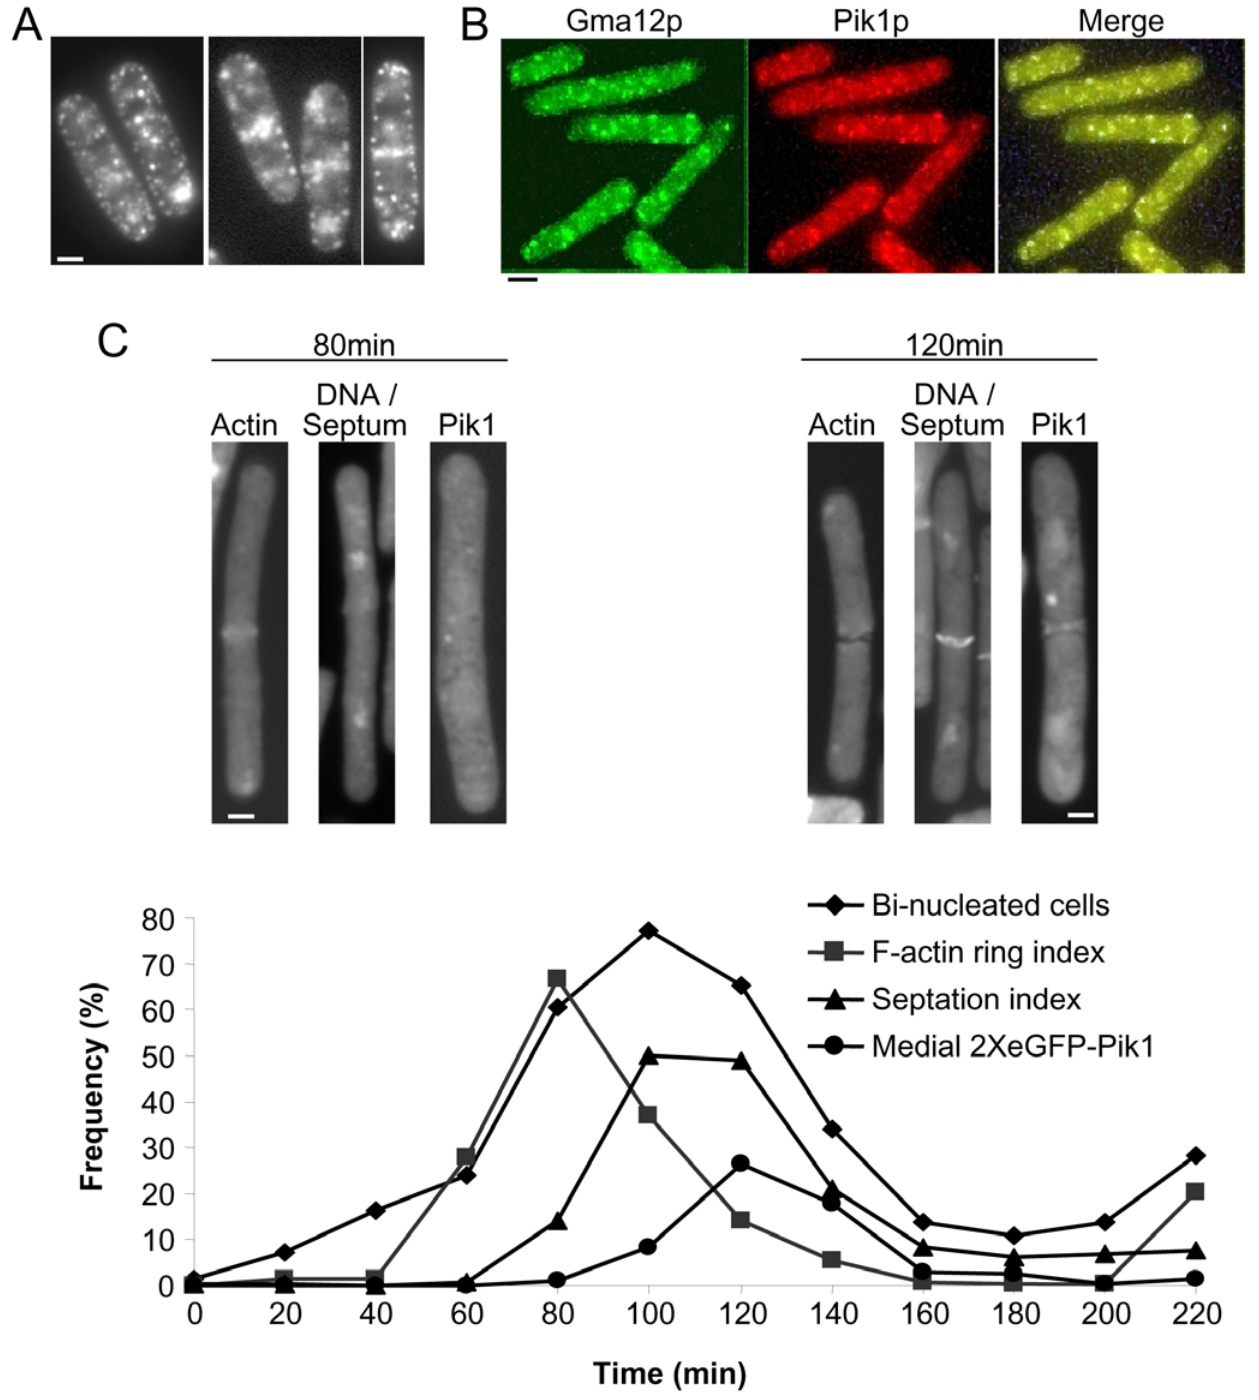
Figure 4. Localization of 2XeGFP-Pik1 in cells in asynchronous cultures, or in cultures synchronized by cdc25-22 block and release. (A) N1369 cells carried D pik1::ura4 and pREP41-2XeGFP- pik1 . The plasmid expressed 2 eGFP moieties, fused tandemly to the N-terminus of Pik1. Cells were cultured for 24 h at 30 u C in the absence of thiamine. Punctate fluorescence was observed throughout the cytoplasm and around the periphery. A medial fluorescent band was observed in 8% of the cells. (B) Cells that carried a GFP-tagged allele of Gma12p (a Golgi-associated galactosyltransferase) were cultured for 24 hours at 30 u C, fixed with methanol and processed for indirect immunofluorescence staining with rabbit antiserum against Pik1p and Texas Red conjugated, goat anti-rabbit antibodies. Cells were examined for Gma12p-GFP fusion (green) and Pik1p (red) and the images merged for colocalization (yellow). (C) N1401 cells which carried cdc25-22 and pREP41-2XeGFP- pik1 were synchronized by block and release. Cells were accumulated at G2/M by incubation at 36 u C for 4 h and released to 25 u C (time=0 minute). Aliquots were taken every 20 minutes N for microscopic examination for binucleate cells (nuclear DNA visualized with DAPI, ¤ ), F-actin ring index (visualized with FITC-phalloidin, & ), ). Representative images are shown for septation index (visualized with calcofluor white, m ) and 2XeGFP-Pik1 fluorescence at the medial region ( cells collected 80 and 120 minutes after release from the temperature block. Results are representative of two independent experiments. Bars, 2 m m.